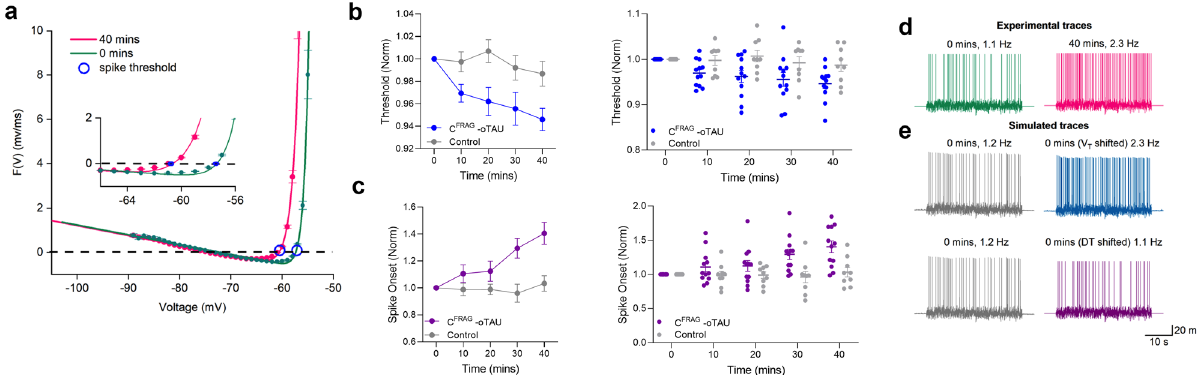
Fig. 4 oTau-mediated hyperpolarising shift in spike initiation threshold. For the dynamic I – V protocol, a naturalistic current is injected into the cell, and the recorded voltage is then used to extract a set of parameters (resting potential E , time constant τ and spike-threshold voltage VT ; see “ Methods ” for more details). The second point where the DIV curve crosses 0 mV/ms is the spike initiation threshold. a Representative examples of dynamic IV curves, for a neuron with the N-terminal truncation of tau (C FRAG -oTau) introduced, generated at 0 min (green) and after 40 min (pink). A hyperpolarising shift in spike initiation threshold of 4 mV (more negative) can be observed (circles on the graph). Panels b and c display both average data (mean ± SEM) as well as individual data points for each condition over time. b The mean normalised spike-threshold data (to value at time 0) is plotted against time. There was no signi fi cant difference between the spike initiation threshold in control vs C FRAG neurons at time 0 (whole-cell breakthrough), thus the recordings were comparable (mean threshold in control neurons was − 53.82 ± 1.46 mV, n = 12 cells, compared to the mean threshold in C FRAG neurons which was − 53.7 ± 1.64 mV, n = 12 cells, P = 0.5185). In control neurons, there was no signi fi cant difference in spike threshold over the duration of the recording (at 40 min, the spike threshold was 101.3± 1.1% of the value at time 0 min, P = 0.4766). Whereas for neurons where C FRAG was introduced, the spike initiation threshold was signi fi cantly reduced (more negative) at 40 min was compared to 0 min (at 40 min, the spike threshold was 94.5 ± 0.9% of the value at time 0 min, P = 0.0010). c Graph plotting spike onset against time. There was no signi fi cant difference between the onset in control vs C FRAG neurons at time 0 (whole-cell breakthrough), thus the recordings were comparable in quality and stability (mean spike onset in control neurons was 1.01 ± 0.09 mV, n = 12 cells, compared to the mean threshold in C FRAG neurons which was 0.98 ± 0.13 mV, n = 12 cells , P = 0.1285). In control neurons, there was no signi fi cant difference in spike onset over the duration of the recording (at 40 min, the spike onset was 103.2 ± 5.7% of the value at time 0 min, P = 0.9102). Whereas for neurons where 444 nM aggregated C FRAG -tau was introduced, the onset was increased (steeper, re fl ecting increased excitability) at 40 min was compared to 0 min (at 40 min, the spike onset was 140.4 ± 8.2% of the value at time 0 min, P = 0.0015). The increase in spike onset observed in neurons where C FRAG -oTau was introduced re fl ects faster spike generation after the threshold was reached. d Membrane-potential responses to naturalistic current injection for the neuron analysed in ( a ) demonstrates an increase in fi ring rate mediated by the introduction of C FRAG -tau oligomers. e Simulated (refractory integrate and fi re model) membrane-potential responses produced from the extracted neuronal parameters at time 0 min (green). The fi ring rate in the simulation is a good match to what was measured experimentally. The spike threshold was shifted by − 4 mV and the simulation re-run (blue). The increase in fi ring rate was comparable to the experimental data at 40 min ( d ). The same procedure was performed, but only with a shift in the spike onset. This had little effect on the fi ring rate, thus con fi rming that the increase in fi ring rate is predominantly mediated by a shift in spike threshold. Error bars represent the standard error of the mean